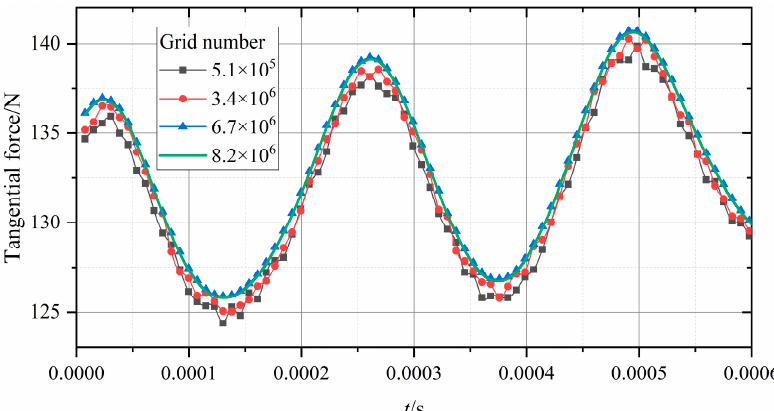
Figure 4. Grid independence verification.